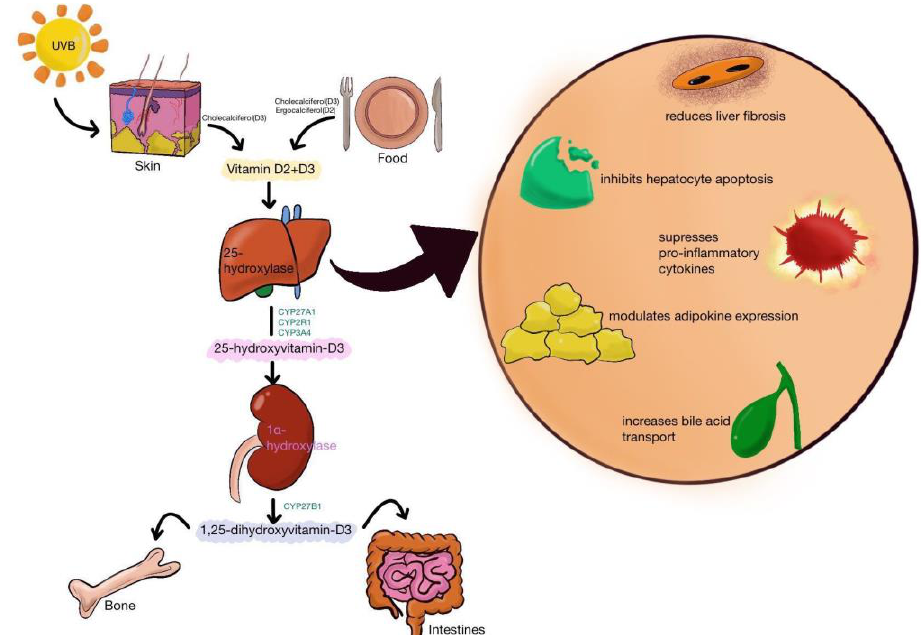
Figure 2. Vitamin D2 and Vitamin D3 metabolism and its different roles in the liver: reduce fibrosis, inhibit hepatocytes apoptosis, suppress pro-inflammatory cytokines, modulate adipokines expressions, and increase bile acid transport.